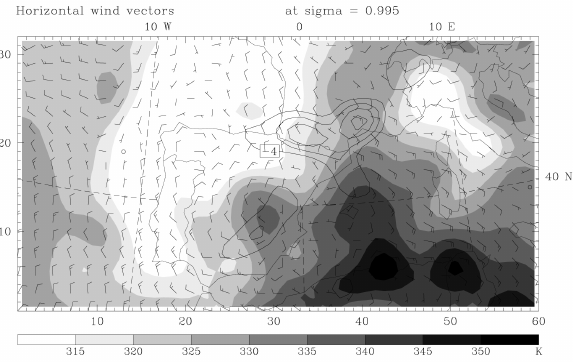
Fig. 6. 24-h backward trajectories for Barcelona (see Fig. 3) for 19:00 UT on 14 September 1999. These back trajectories started at 19:00 UT on 13 September 1999. Trajectories are marked with the atmospheric level (hPa) they reached in Barcelona (SRF: